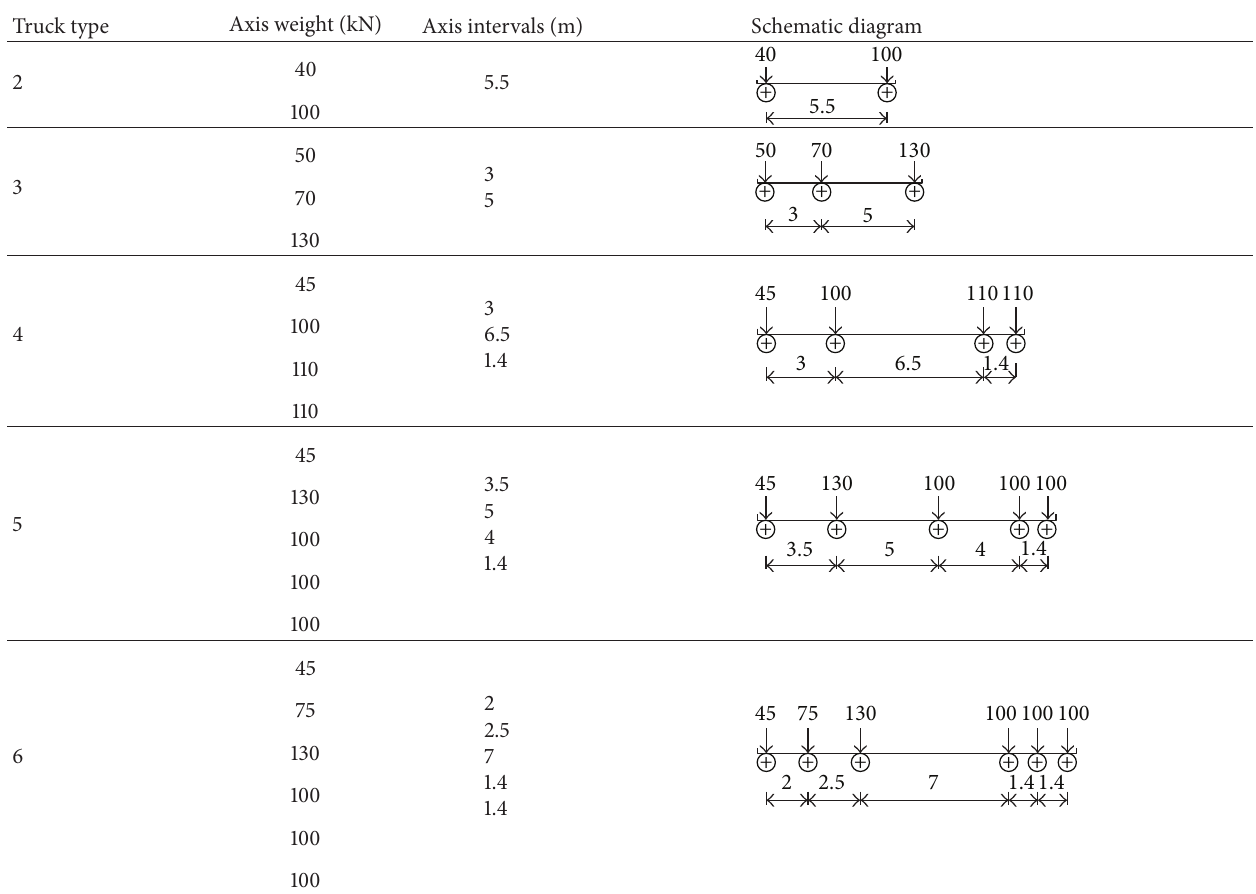
Table 2: Typical style for vehicle